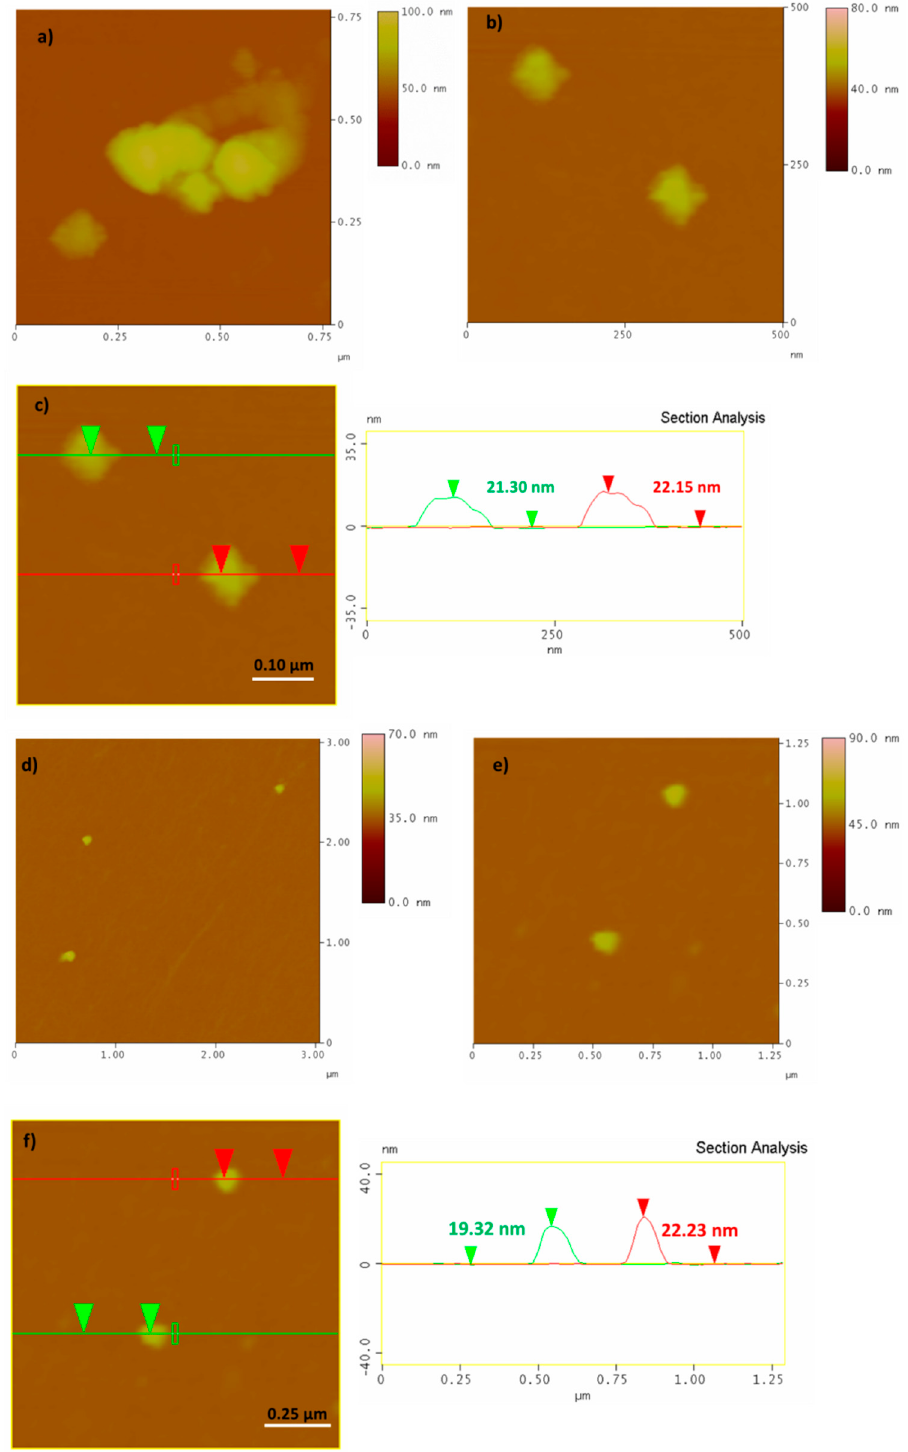
Figure 7. AFM height images and cross section analysis of PCC-Tmbgl ( a – c images) and PCCox -Tmbgl ( d – f images).